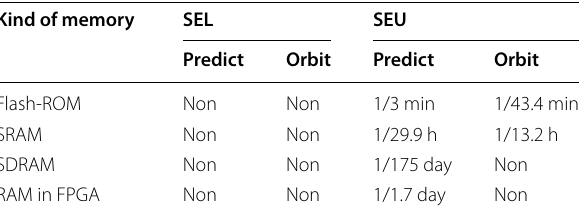
Table 2 1-bit in-orbit and predicted radiation error